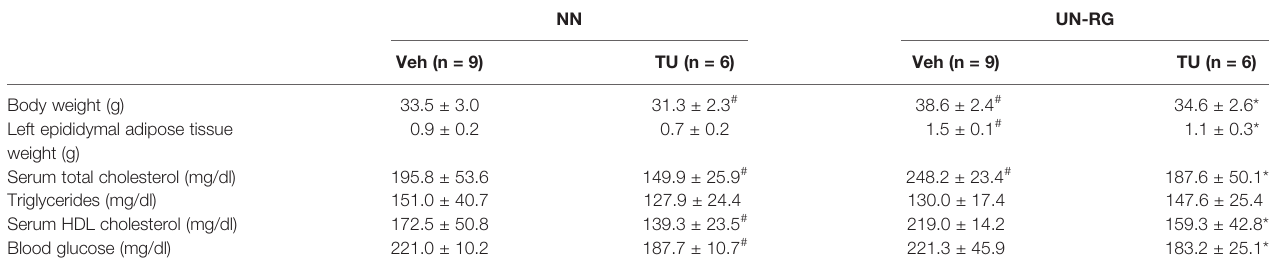
TABLE 2 | Body weight, adipose tissue weight, and lipid and glucose levels in blood at 16 wks.